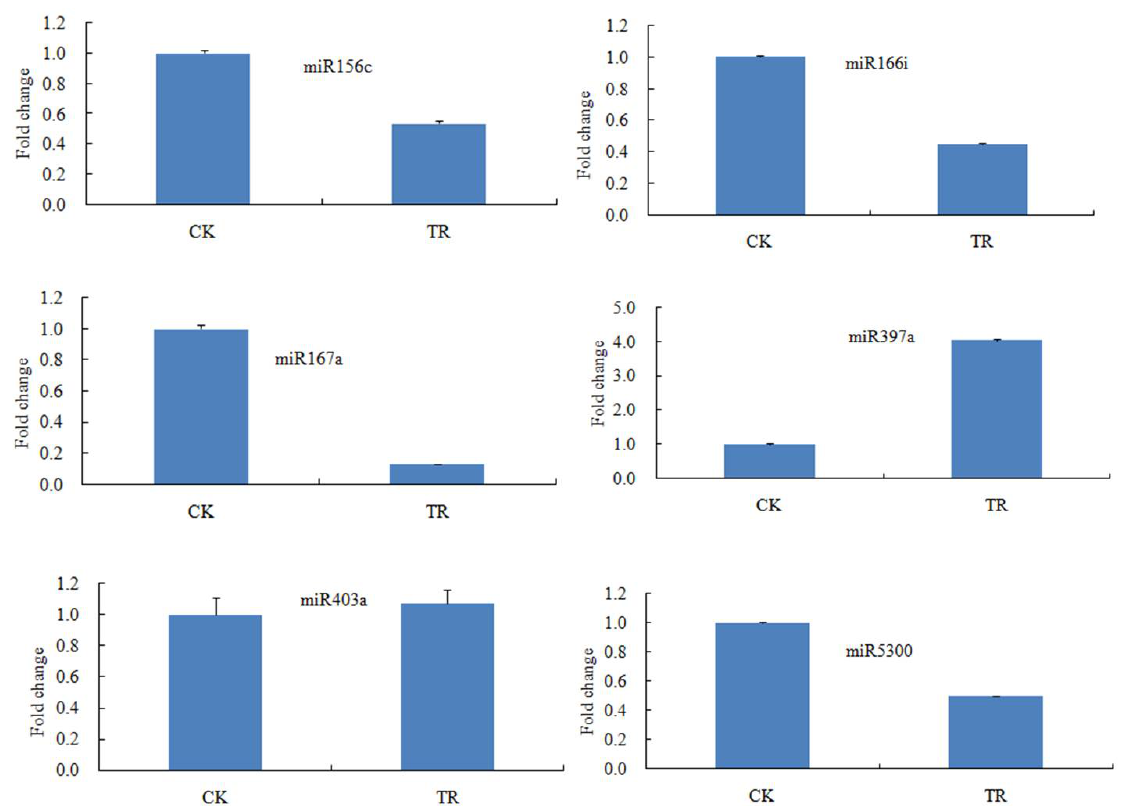
Figure 2. Validation of selected miRNAs in roots by qRT-PCR. The data are the average of three qRT-PCR replicates for each sample from three biological repeats. Small nuclear RNA U6 is used as an internal reference. Error bars indicate one standard deviation of three different biological replicates. The expression changes of six miRNAs detected by qRT-PCR are consistent with the Illumina sequencing